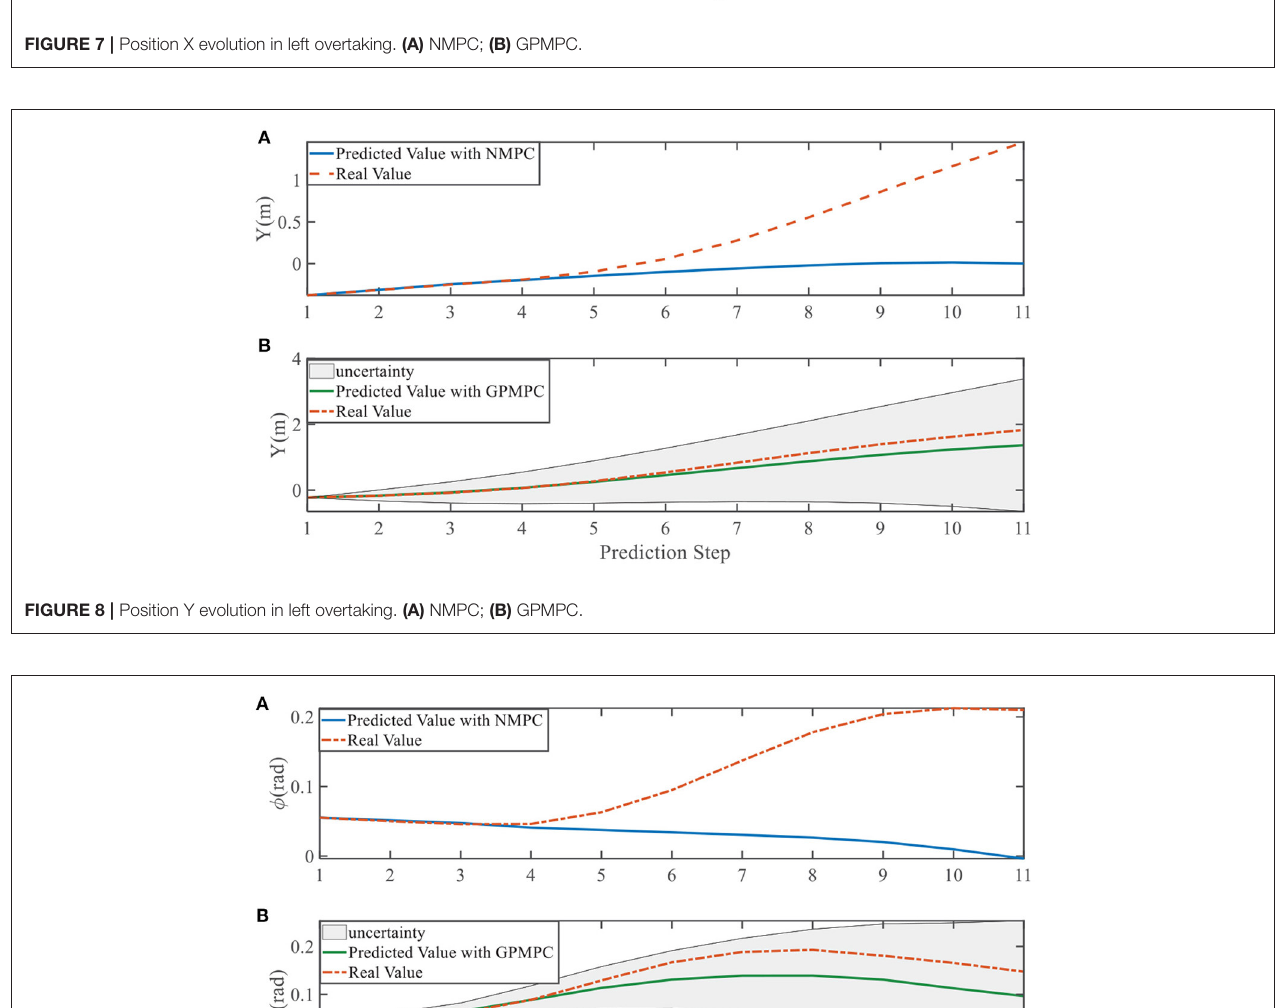
Frontiers in Neurorobotics |